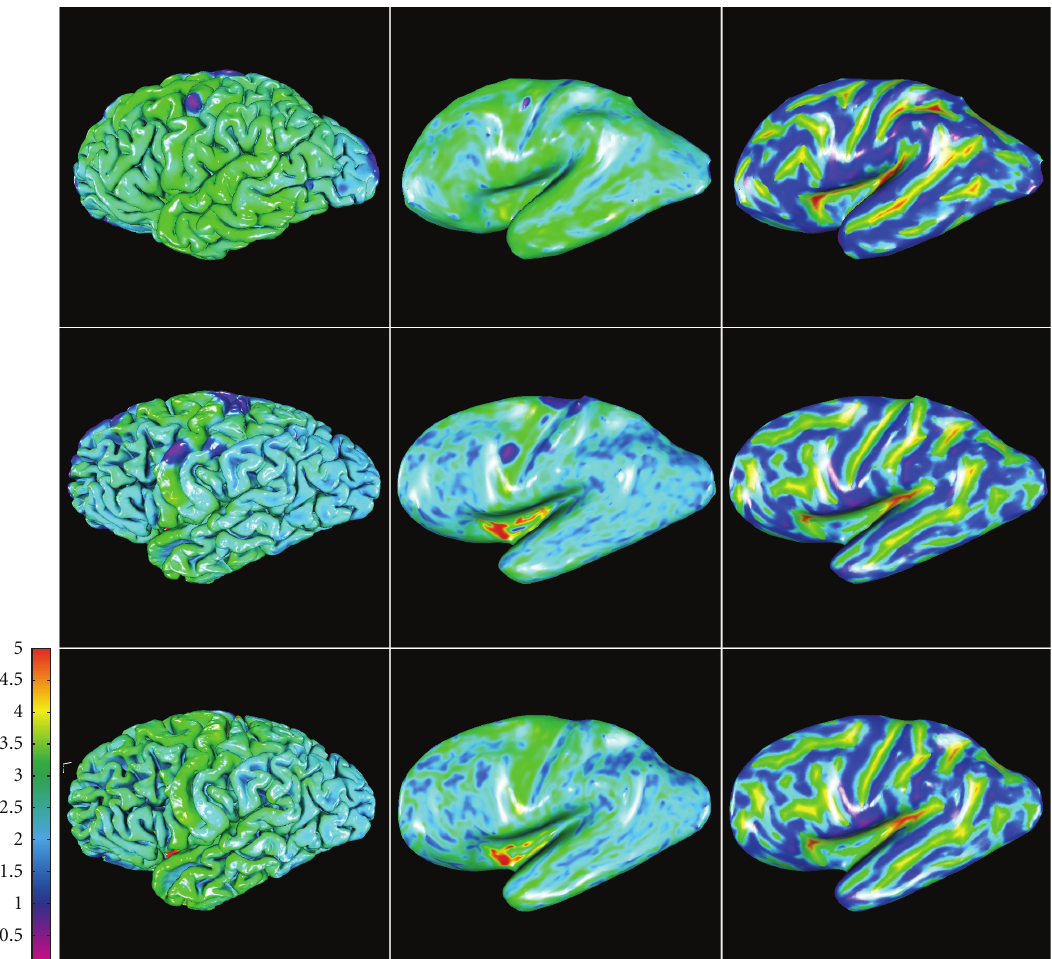
Figure 7: Lateral view of pial surfaces from three high-resolution datasets (left column: thickness maps; middle column: inflated thickness maps; right column: inflated convexity